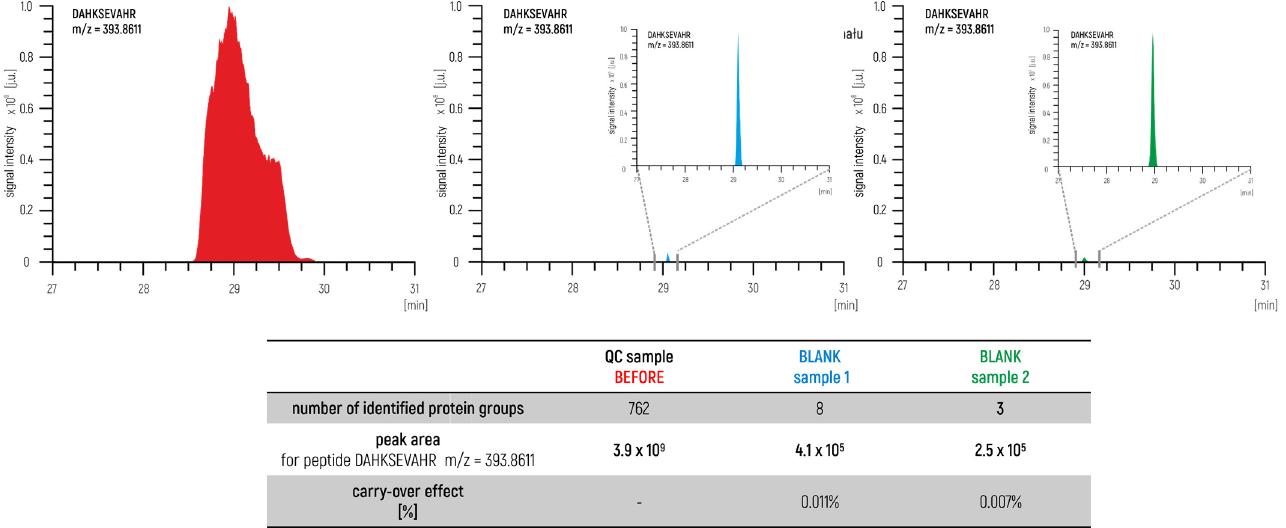
Figure 3. Monitoring the carry-over effect in an LC–MS/MS system using a control sample and a blank sample (XIC chromatograms for peptide DAHKSEVAHR m/z = 393.8611 and comparison of selected